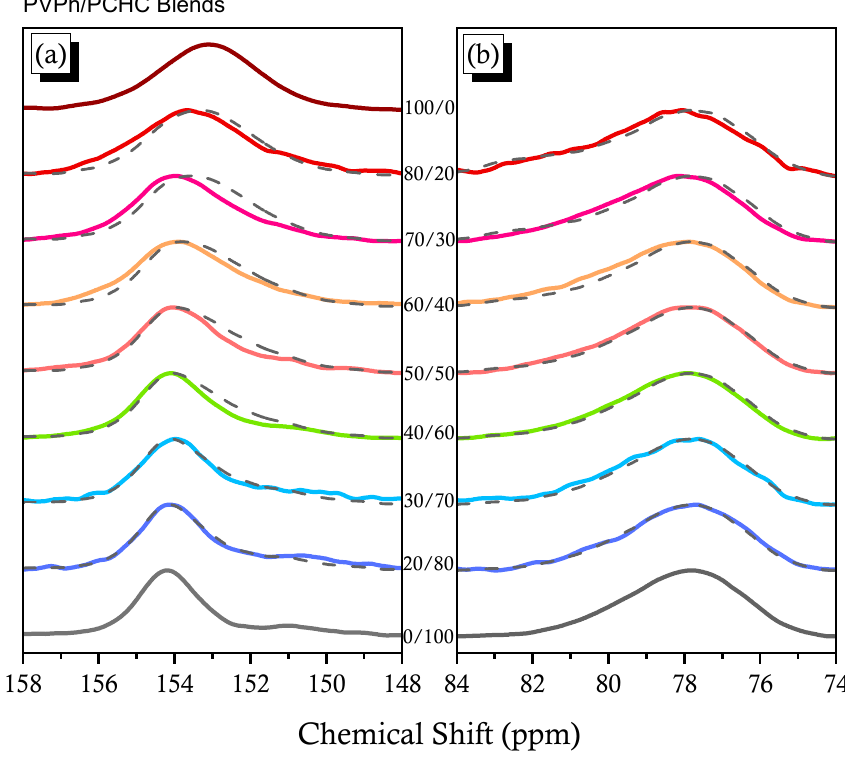
Figure 7. Selected carbon nuclei in solid state 13 C NMR spectra: ( a ) C–OH and C=O carbon nuclei of PVPh and PCHC and ( b ) C–O carbon nuclei of PCHC.